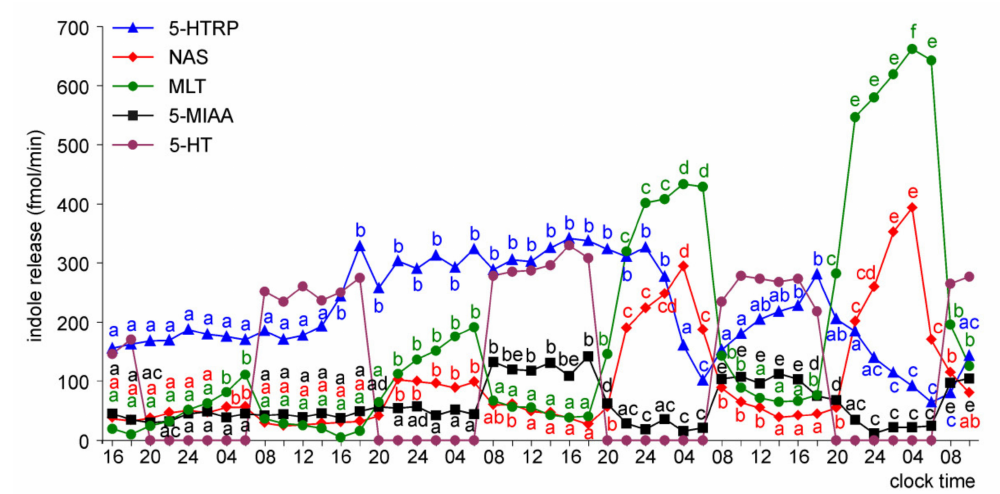
Figure 13. Release of 5-HTRP, NAS, MLT, and 5-MIAA (means, n = 3) from pineal organs of ED 22 embryos incubated under a 12L:12D cycle and treated with NE during photophase. The same letters indicate means, which are not significantly different between